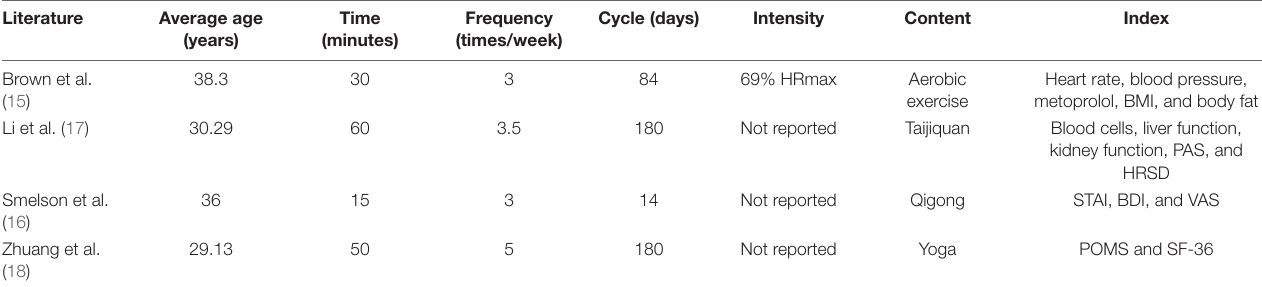
TABLE 2 | List of information on exercise intervention programs for people with opioid use disorder. Literature